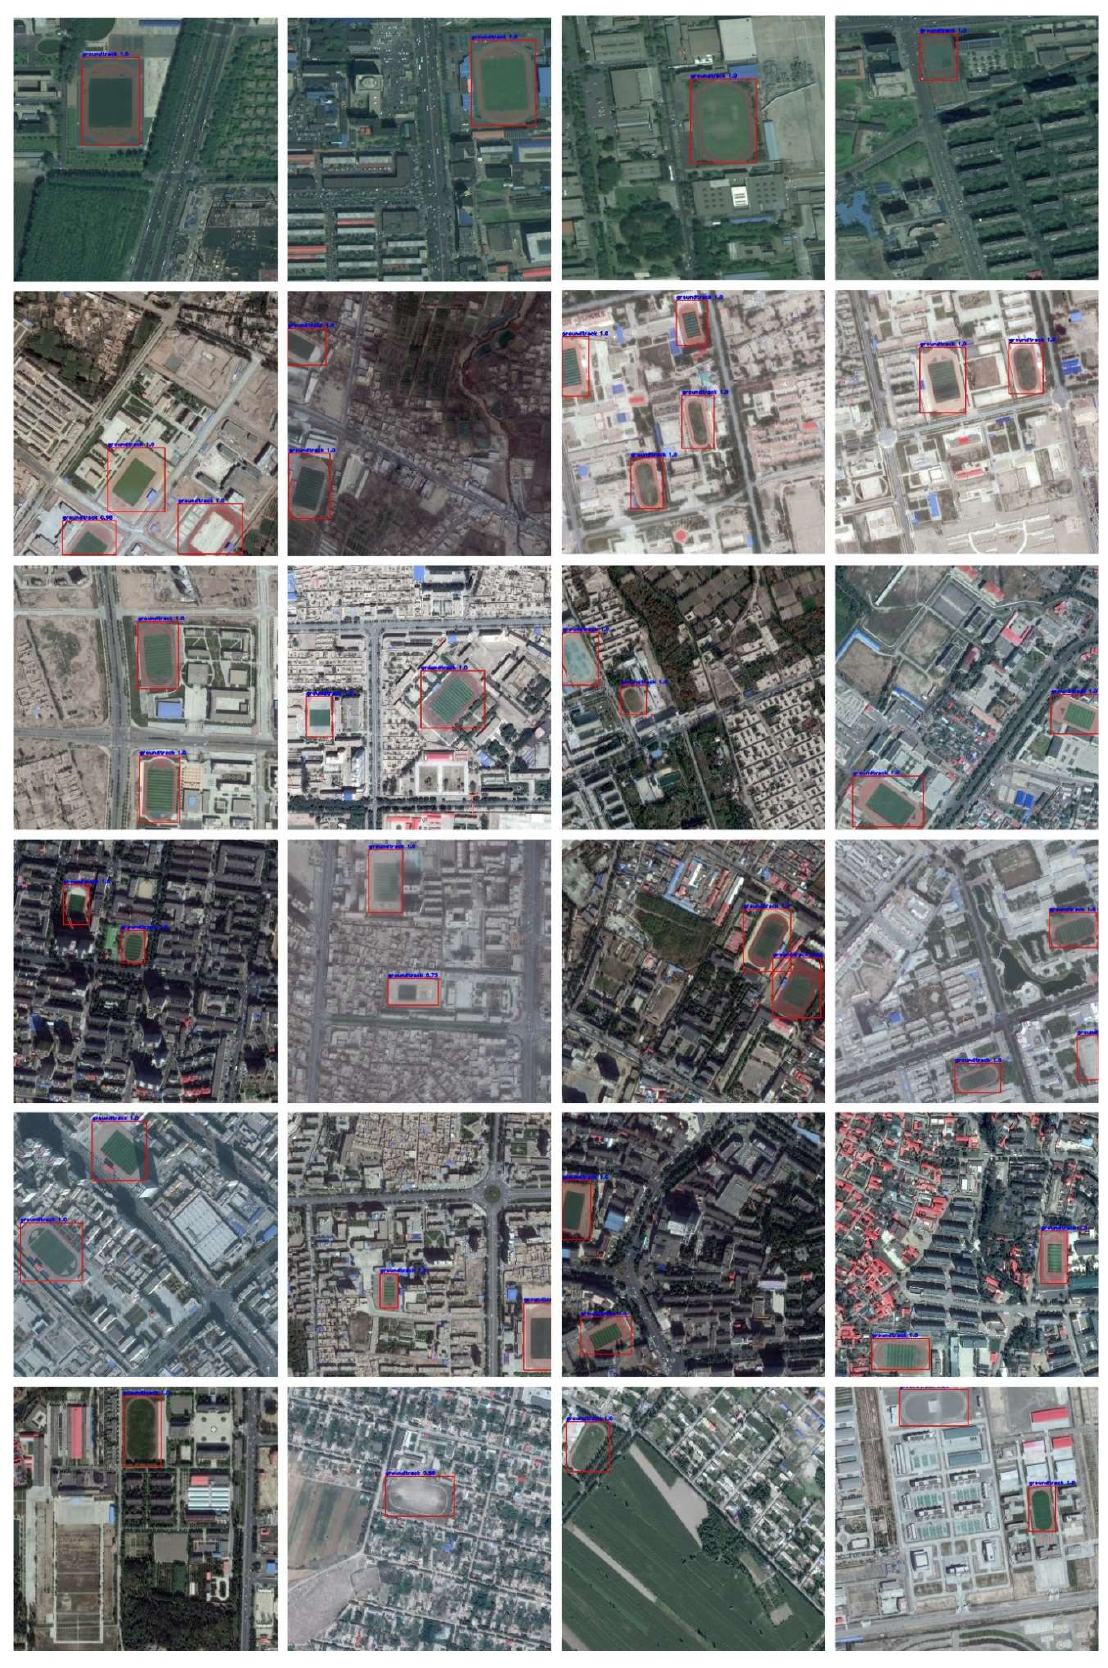
Figure 13. Detection examples on track and fields in China by MSF_SSD.